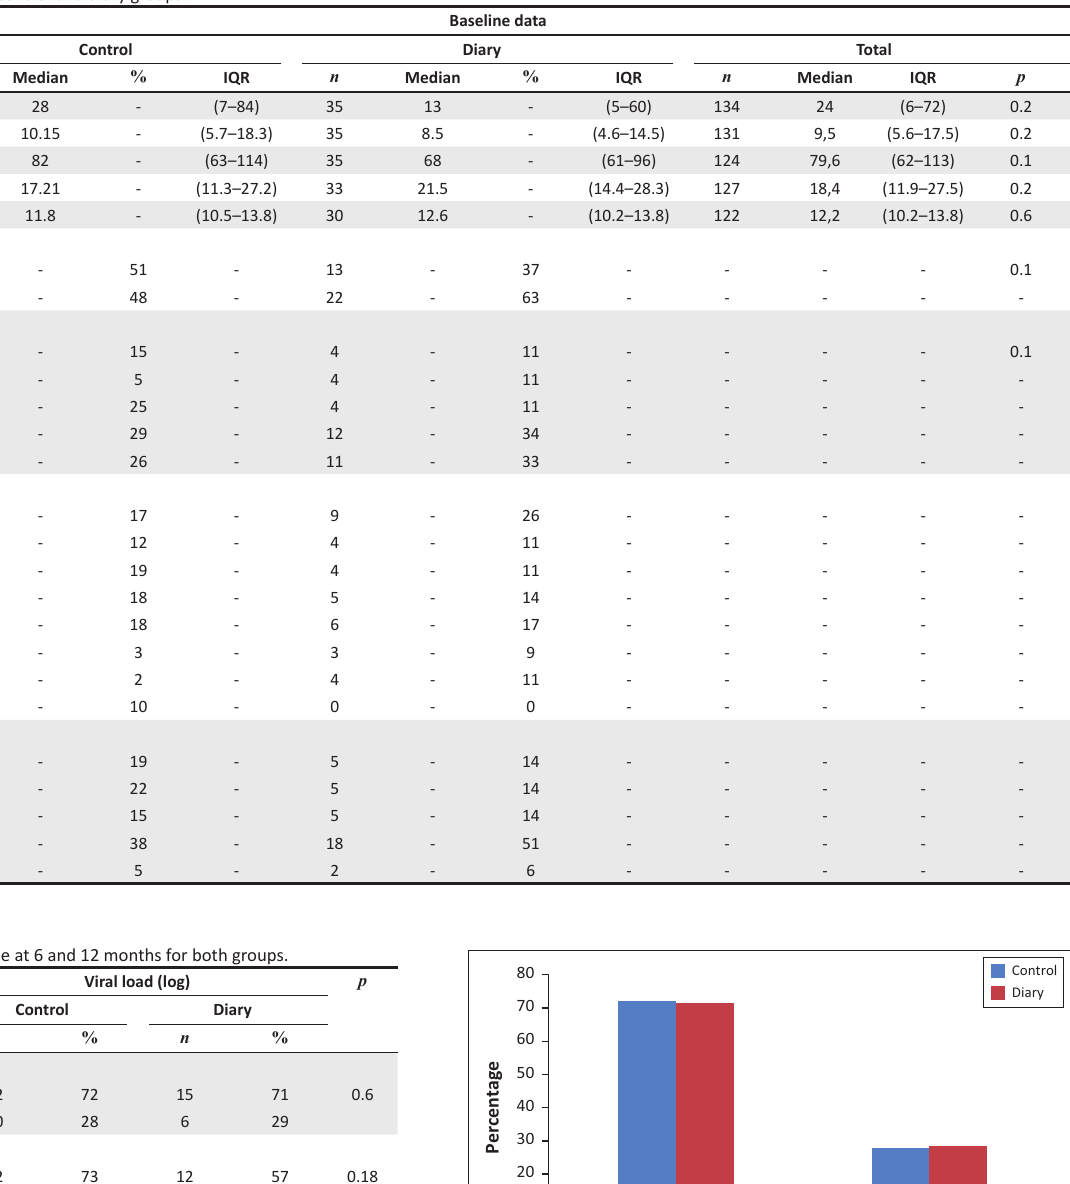
TABLE 1: Baseline data for control and diary groups.